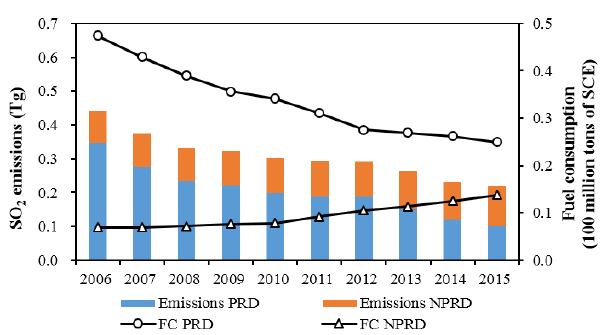
Figure 6. Trends of SO 2 emissions (left axis) and fuel consumption (right axis) from industrial combustion from 2006 to 2015. SCE represents standard coal equivalent; FC represents fuel consumption (i.e., coal, fuel oil, coke, and natural gas), and all of the FC data are normalized to the year